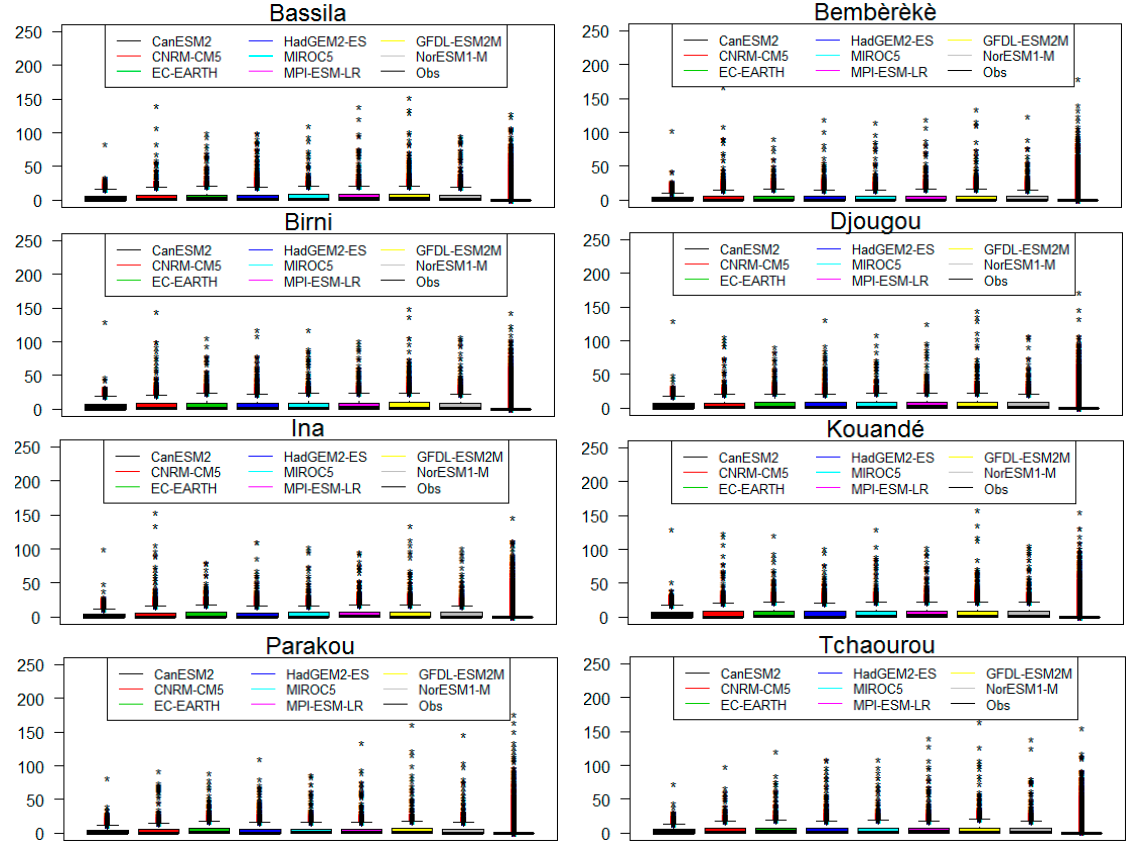
Figure 2. Boxplot of observed and simulated daily rainfalls over the period 1951–2005.